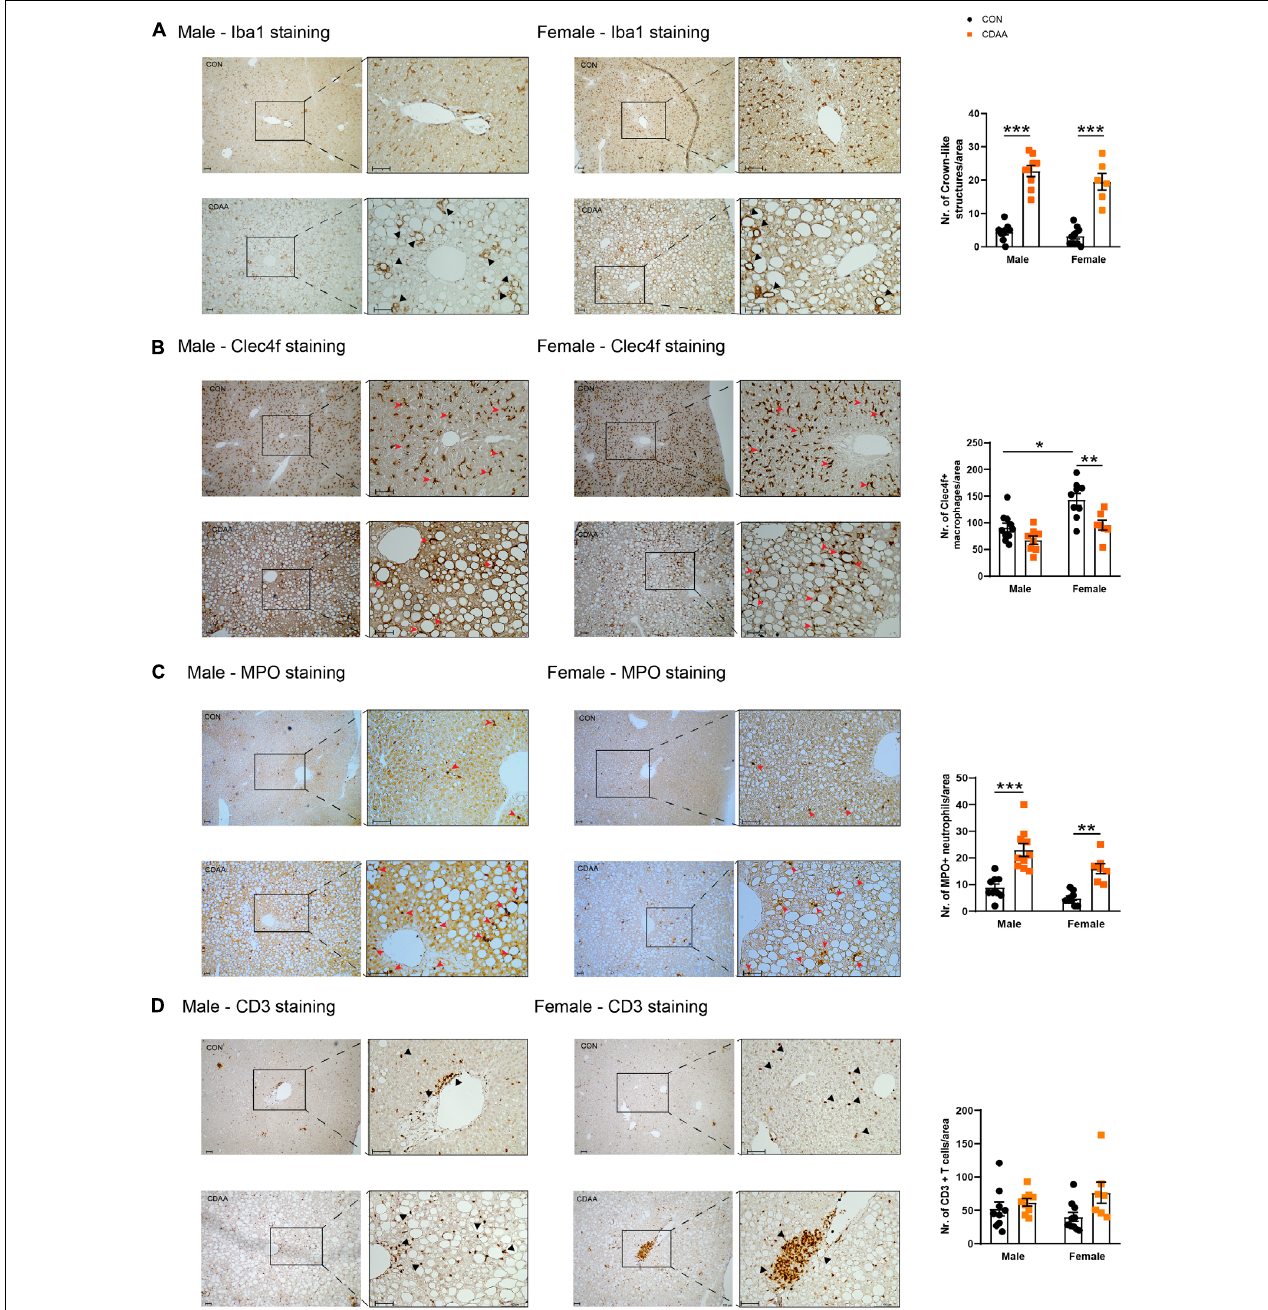
FIGURE 5 | Hepatic inflammatory cell infiltrates in CDAA-induced NASH. The extent of liver inflammation was evaluated by immunohistochemical assessment and quantification of the presence of macrophages/monocytes on hepatic sections by Iba1 staining (A) and by the assessment and quantification of Clec4f positive resident Kupffer cells (B) . Infiltrating neutrophils are shown by MPO staining (C) . Average number of infiltrating neutrophil granulocytes on microscopic images were counted from hepatic histological sections (C) . Immunohistochemical assessment and quantification of the presence of T cells by CD3 staining (D) . Black and red arrows point to corresponding infiltrating cells. Scale bar indicates 100 µ m. Results are shown as mean ± standard error of mean (SEM). * P < 0.05 was considered significant, ** P < 0.01 was considered significant, *** P < 0.001 was considered